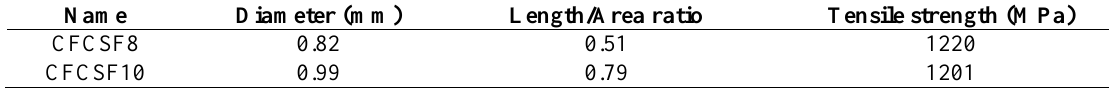
Table 2. Features of utilized steel fibers